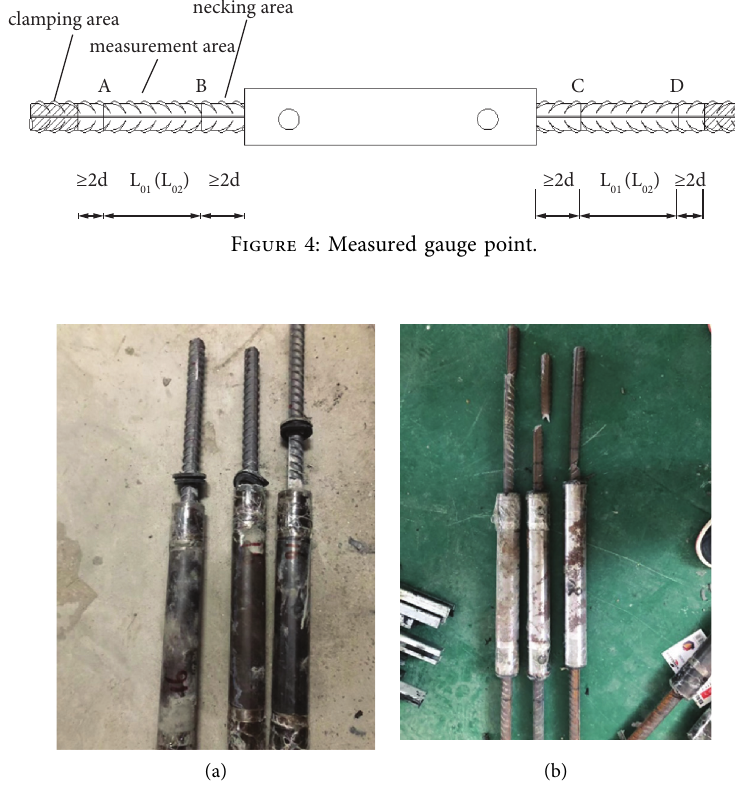
Figure 5: The failure mode of the specimen. (a) Rebar pullout. (b) Rebar tension fracture. Table 3: Specimen loading test results.